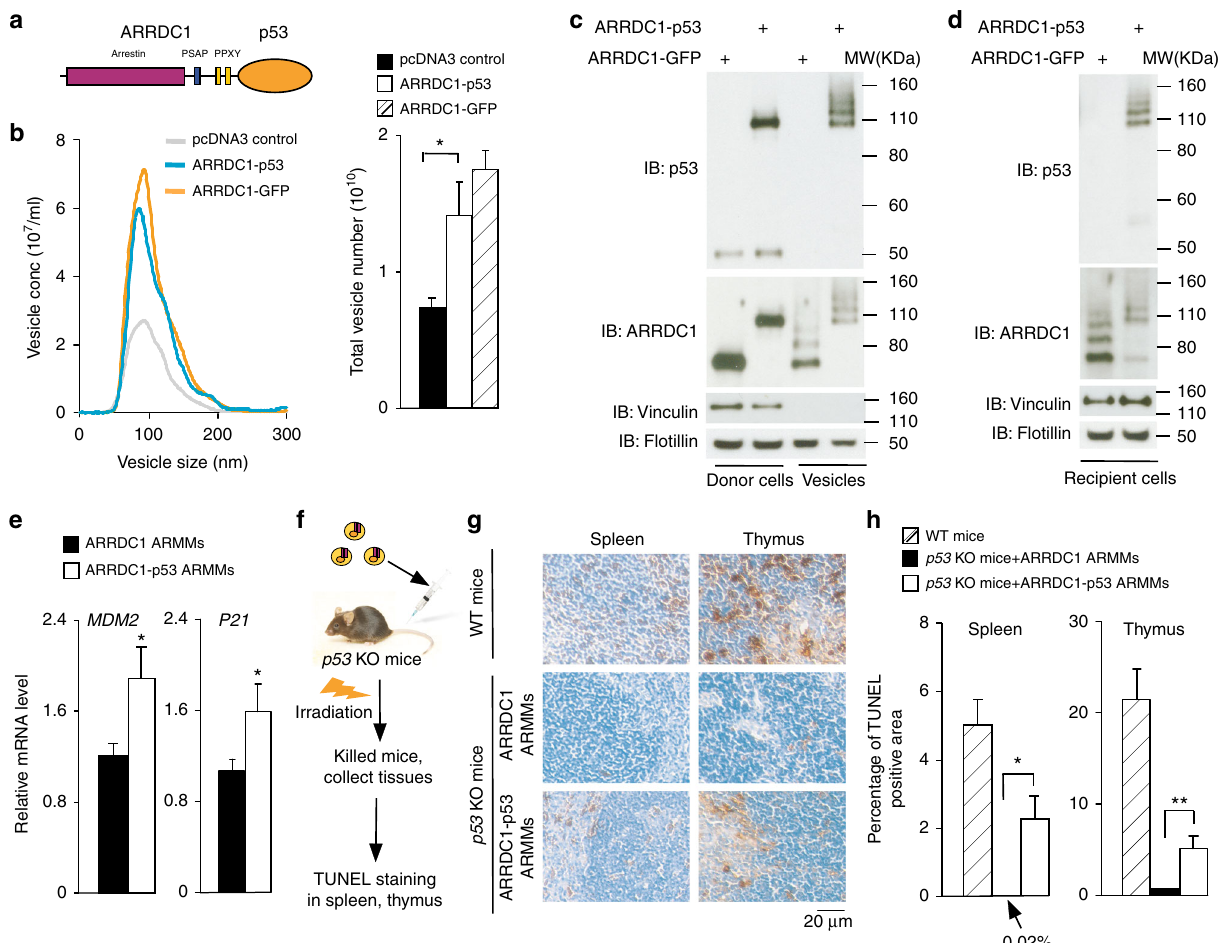
Fig. 1 Packaging and in vivo delivery of p53 protein via ARMMs. a Schematic showing p53 fused to the C-terminus of ARRDC1. Domains and motifs in ARRDC1 relevant to ARMMs budding are indicated. b Effect of ARRDC1-p53 expression on the production of EVs. pcDNA3, ARRDC1-GFP, or ARRDC1-p53 construct was transfected in HEK293T cells. EVs in the media were analyzed by the NanoSight NS300 instrument (left graph). Numbers of EVs from 3 independent experiments were quanti fi ed (right graph). Data were presented as the mean ± SEM. c Packaging of ARRDC1-p53 into ARMMs. pcDNA3, A1- GFP, or A1-p53 was transfected in the production of HEK293T cells. EVs in medium were pelleted vesicles by ultracentrifugation. Western blotting for p53, ARRDC1, and control protein vinculin was done on both cell lysates and EVs. d Transfer of ARRDC1-p53 fusion protein in ARMMs to recipient cells. Puri fi ed ARMMs containing ARRDC1-GFP or ARRDC1-p53 were incubated with H1299 cells overnight. The cells were washed with PBS extensively and subjected to Western blot analysis. e Induction of p53 target genes by ARRDC1-p53 fusion protein delivered via ARMMs. ARRDC1- or ARRDC1-p53 ARMMs were incubated with H1299 cells for 48 h. Total RNAs were extracted from the cells and used for qRT-PCR to measure MDM 2 and p21 mRNA expression. Data were presented as the mean ± SD. The experiments were repeated for fi ve times. f Schematic of in vivo delivery strategy. Control or ARRDC1-p53 ARMMs were injected in the tail veins of p53 knockout (KO) mice, which were then subjected to DNA ionizing radiation. Irradiation-sensitive tissues such as thymus and spleen were harvested for TUNEL staining. g Representative images of TUNEL staining of spleen and thymus from wild type mice or p53 KO mice injected with indicated ARMMs. 2-month old mice ( n = 3 – 4 for each condition) were injected with A1 or A1-p53 ARMMs and 36 h later subjected to irradiation. Age-matched WT animals were used as positive controls for irradiation treatment. Scale bar for the images are shown. h Quanti fi cation of apoptotic (TUNEL-positive) cells in tissue staining images. Data were presented as mean ± SEM. * p < 0.05; ** p <